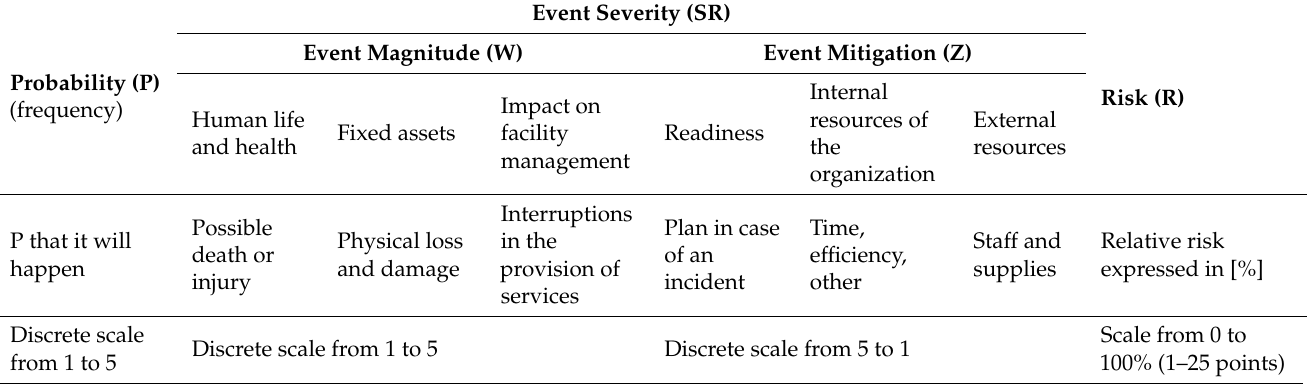
Table 3. Parameters characterizing the probability (P) (frequency) of an event occurrence, the magnitude of the event (W) and event mitigation (Z), and the risk